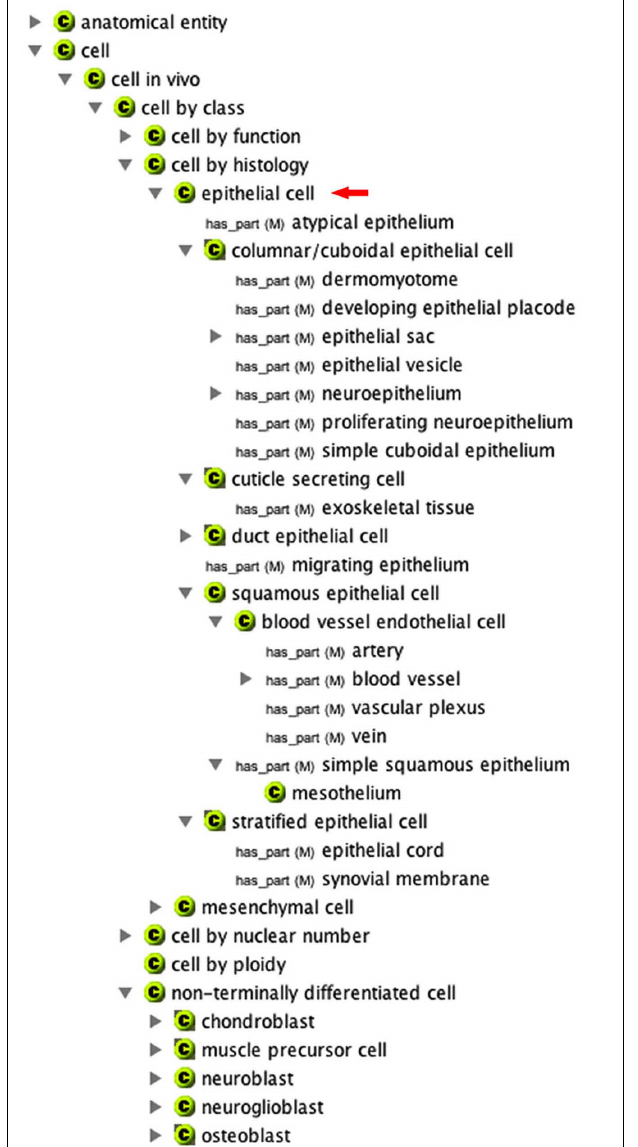
Table 1 |TheAEO obo file entry for autonomic ganglion .